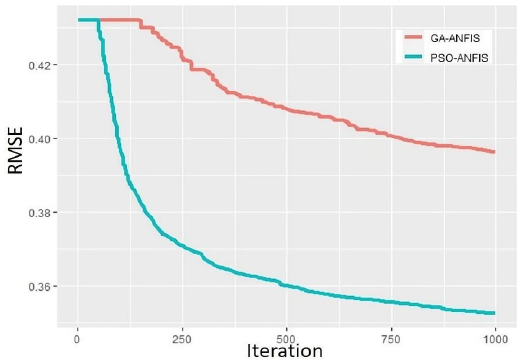
Figure 5. Convergence curve of the fitness function (RMSE) for PSO-ANFIS and GA-ANFIS in case of 1000 iterations.